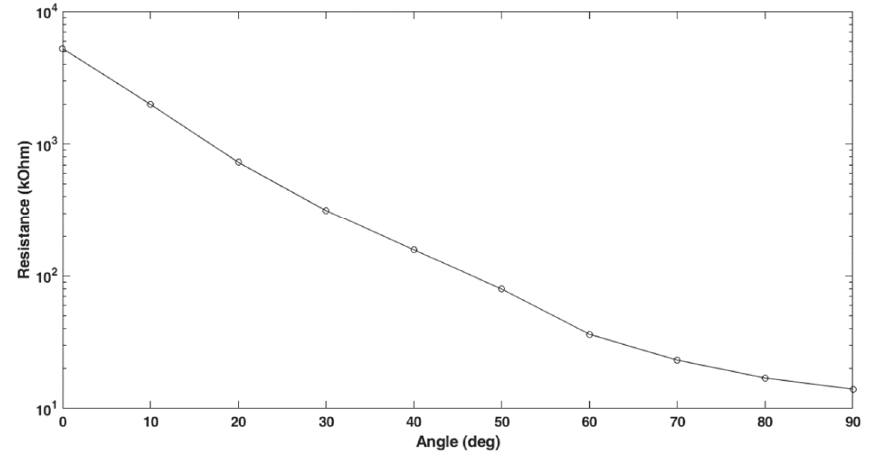
Figure 4. Sensor resistance vs. bending angle. Semilog plot ( y -axis has log scale).